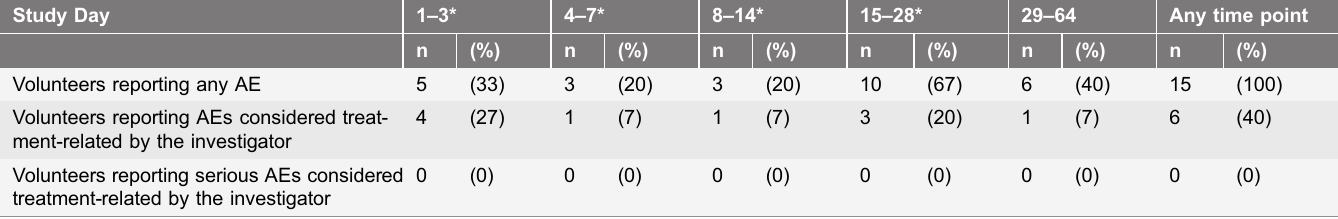
Table 4. Type and timing of adverse events in enrolled volunteers (N 5